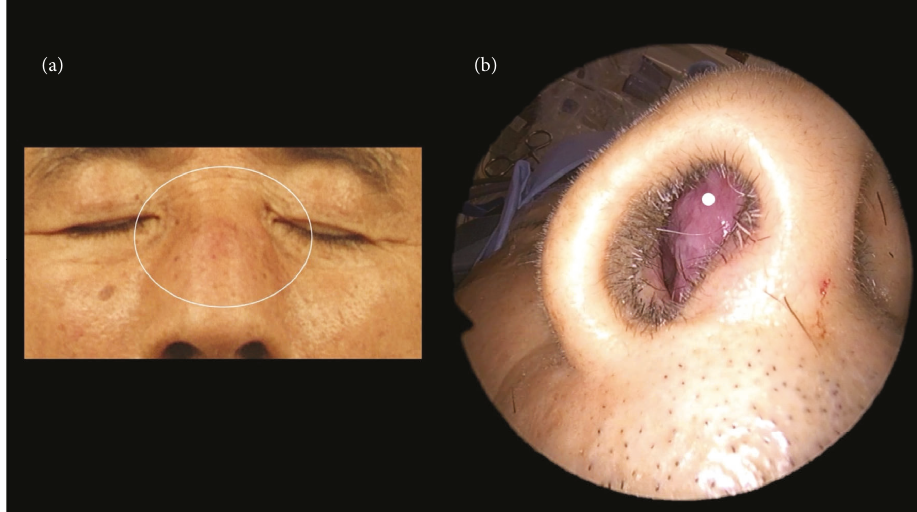
Figure 1: (a). Physical findings of the face showing a swelling of the dorsum of the nose (white circle). (b). Physical findings of the face showing a swelling of the anterior nasal septum of the nose (white dot).